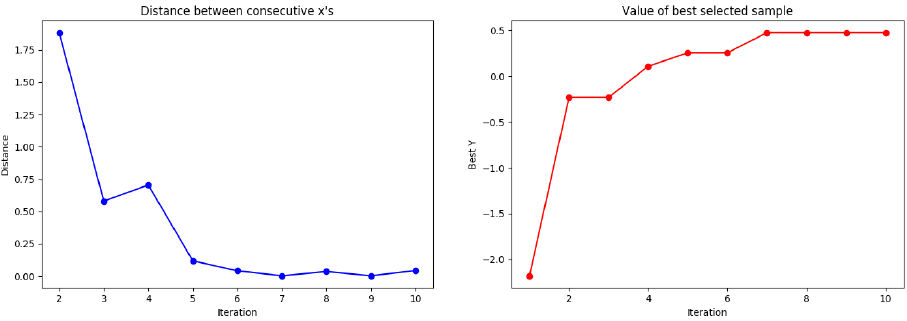
Figure 7. Tested results of distances and the best selected samples to Gamma distribution.